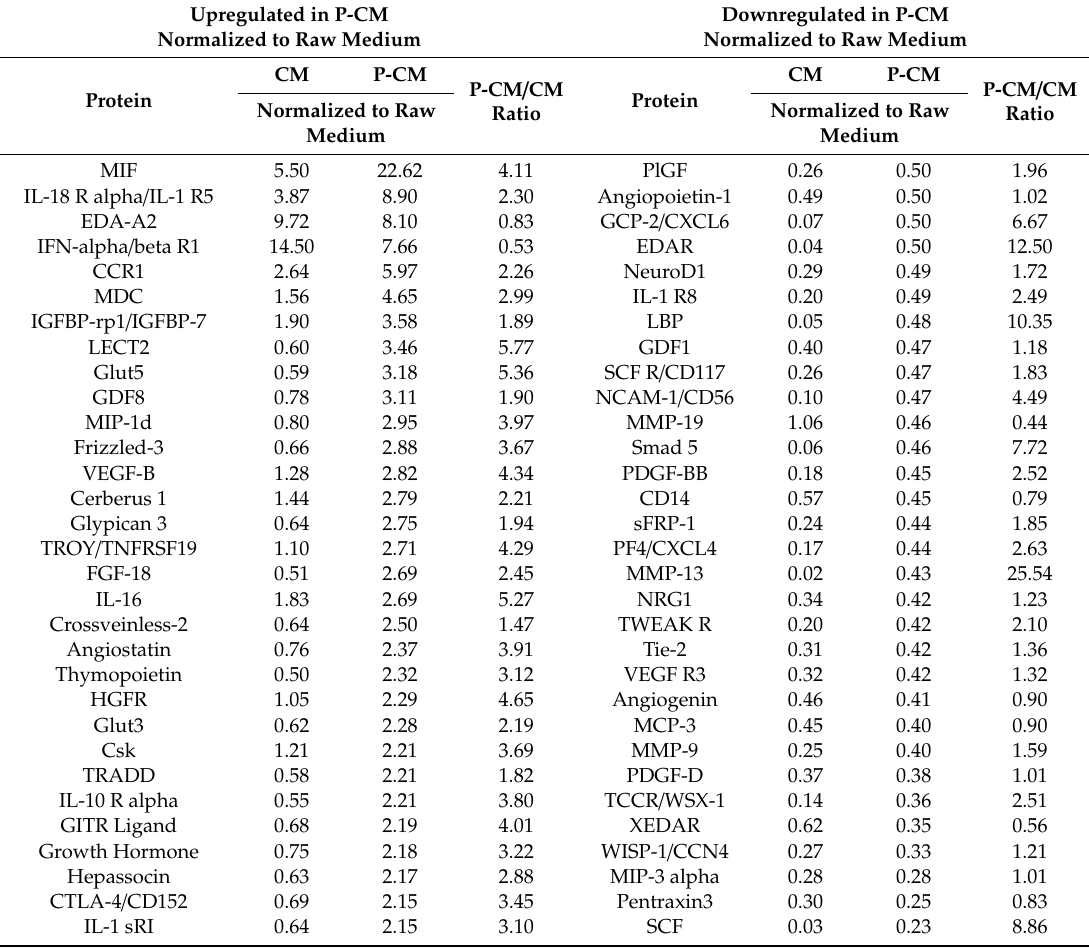
Table 1. Upregulated and downregulated proteins in CM and P-CM. Upregulated in P-CM Normalized to Raw